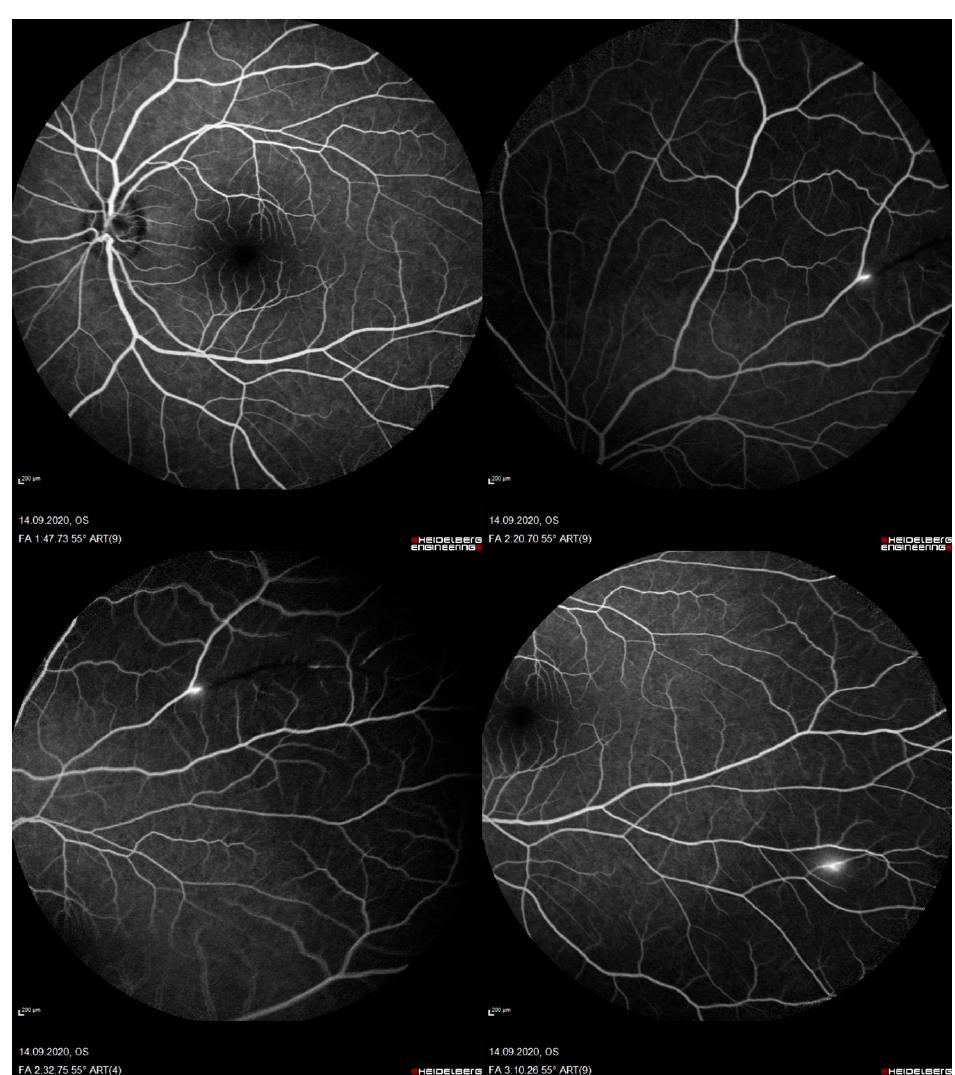
Int. J. Environ. Res. Public Health 2021 , 18 , x FOR PEER REVIEW Figure 2. Fluorescein angiography examination exhibiting branch retinal artery occlusion in the left eye.